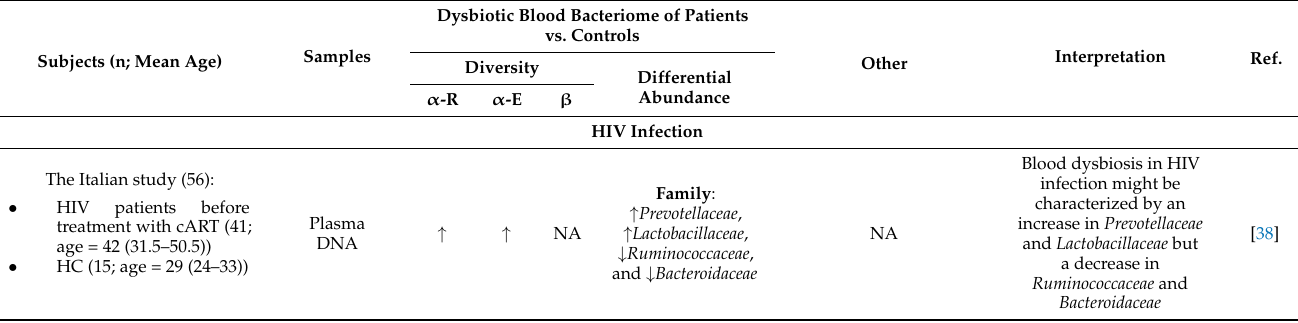
Table 2. Blood Bacteriome Dysbiosis Profiles in Infection-Related